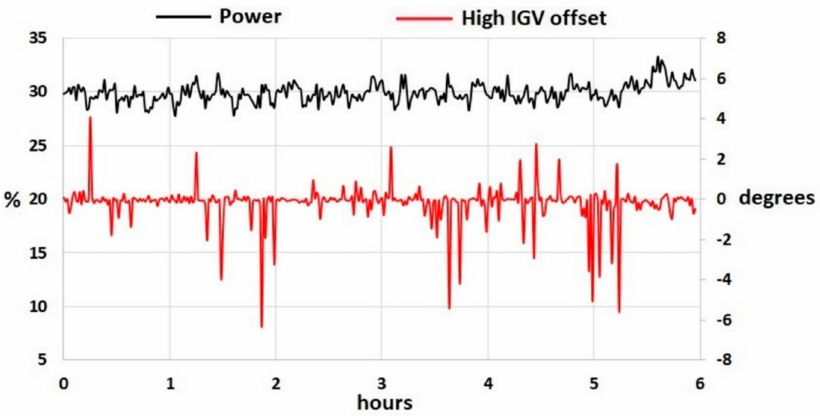
Figure 31. Measured power and at high IGV offset.